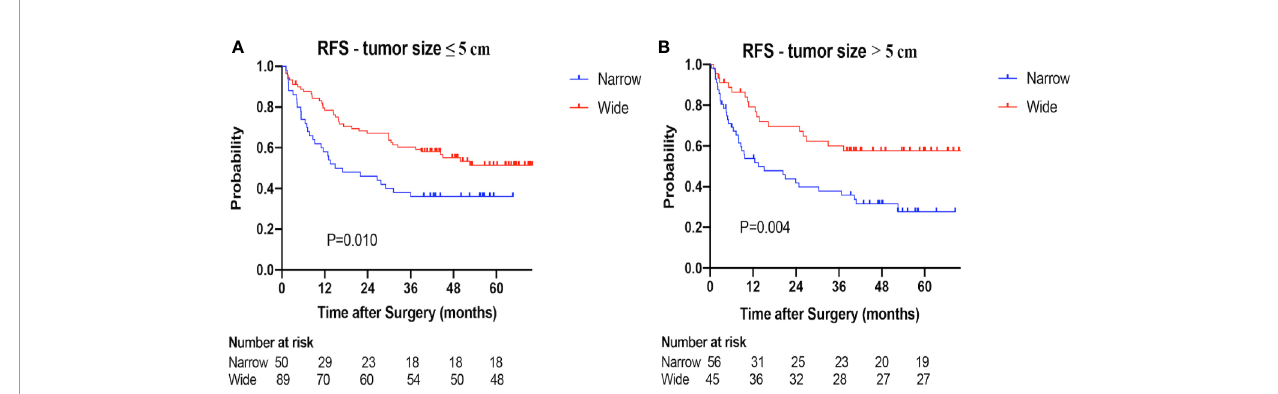
FIGURE 4 | Recurrence-free survival (RFS) of the narrow-margin and wide-margin groups strati fi ed based on tumor size. (A) Recurrence-free survival in the subgroup of tumor size ≤ 5 cm. (B) Recurrence-free survival in the subgroup of tumor size > 5 cm.